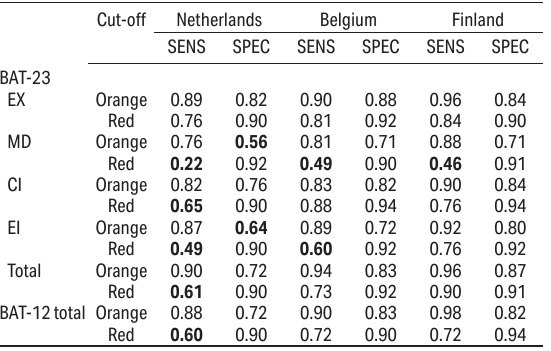
Table 4. Sensitivity (SENS) and specificity (SPEC) using country-specif- ic values for the Burnout Assessment Tool (BAT) [EX=exhaustion; MD= mental distance; CI=cognitive impairment; EI=emotional impairment]. Note : A table of all operating characteristics (sensitivity, specificity, 1-specificity and Youden-index for each BAT score) is available upon request from the first author. Bold denotes